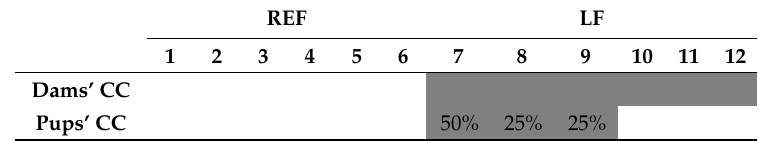
Table 1. Detection of Lactobacillus fermentum CECT5716 in the cecal content (CC) of dams and pups. REF LF